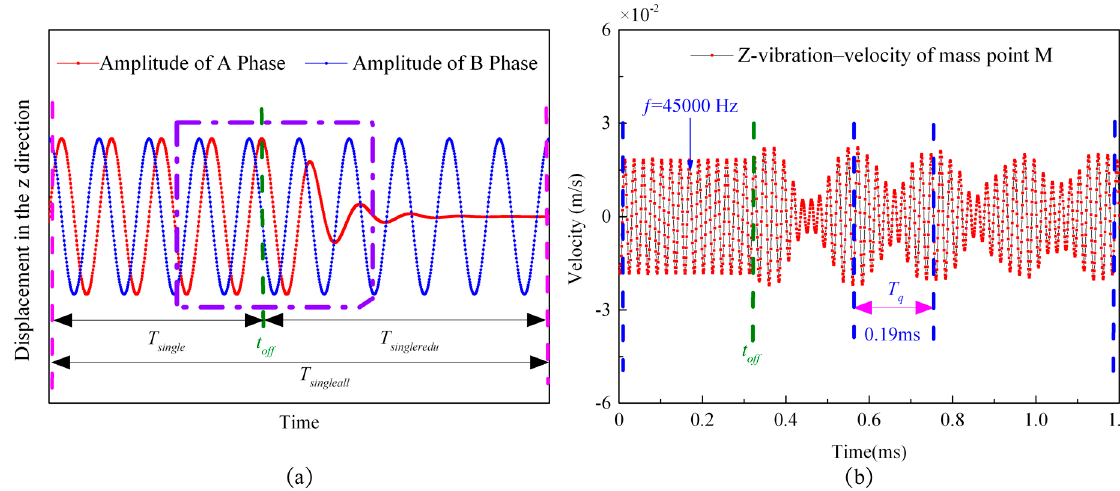
Figure 27. Schematic diagram of the two-phase excitation response in the stator two-phase vibration measurement exper-